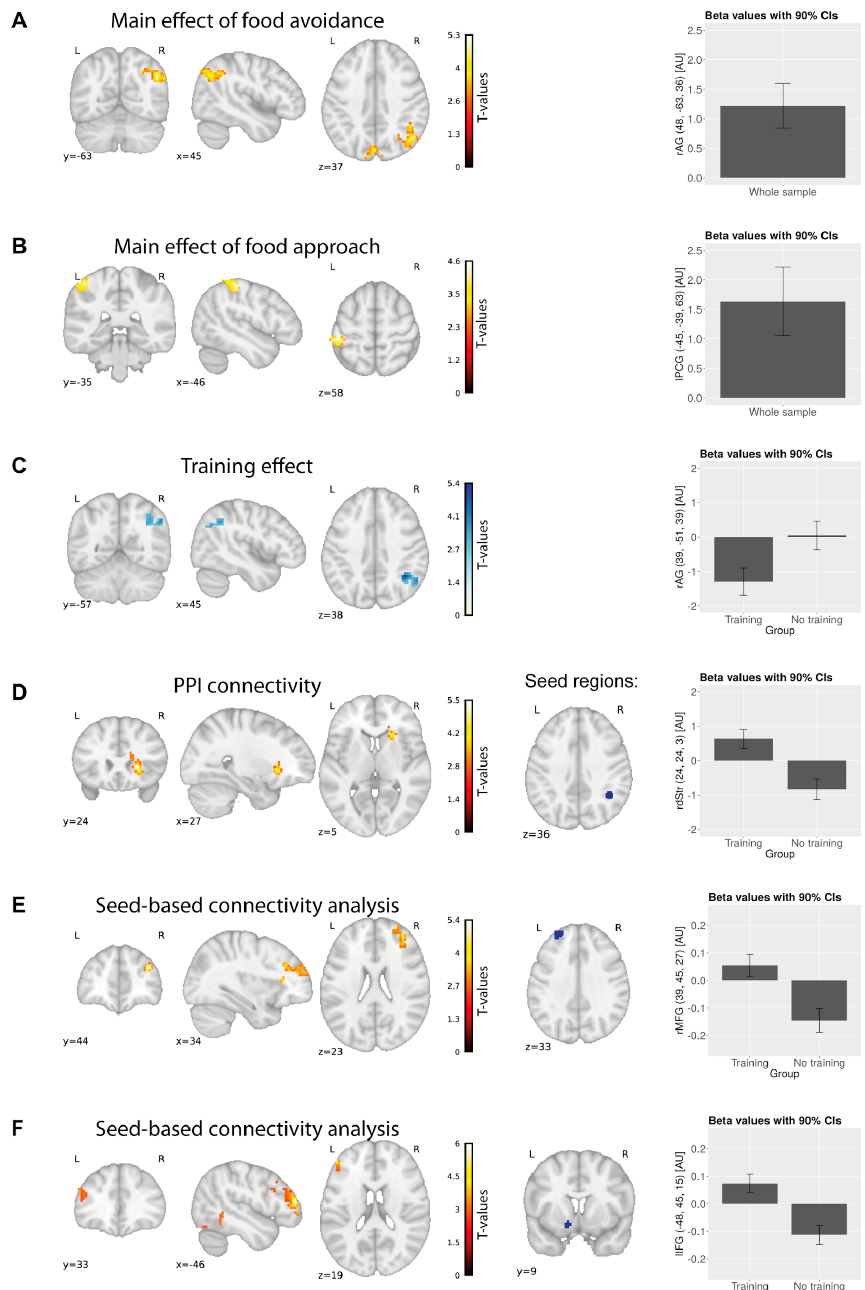
Figure 3. Main effects of food approach/avoidance pre-training in both groups together ( A , B ), and effects of cognitive bias modification (CBM) training along with contrast estimates (arbitrary units); note a different scale in the parameter estimates for subfigures. ( A ): Main effect of food avoidance. ( B ): Main effect of food approach. ( C ): Training effect was reflected in a decreased brain activity in the right angular gyrus for healthy food avoidance vs. unhealthy food avoidance. ( D ): Higher task-related connectivity between the right dorsal striatum and the right angular gyrus in the unhealthy push vs. unhealthy pull condition after training. ( E ): Increased connectivity post-training in the training vs. sham-training group in the left and right middle frontal gyri (resting-state seed-based connectivity analysis). ( F ): Increased connectivity post-training in the training vs. sham-training group in the left nucleus accumbens and inferior frontal gyrus (resting-state seed-based connectivity analysis). rAG: right angular gyrus; lPCG: left postcentral gyrus; rdStr: right dorsal striatum; rMFG: right middle frontal gyrus; lIFG: left inferior frontal gyrus; AU: arbitrary units; CI: confidence